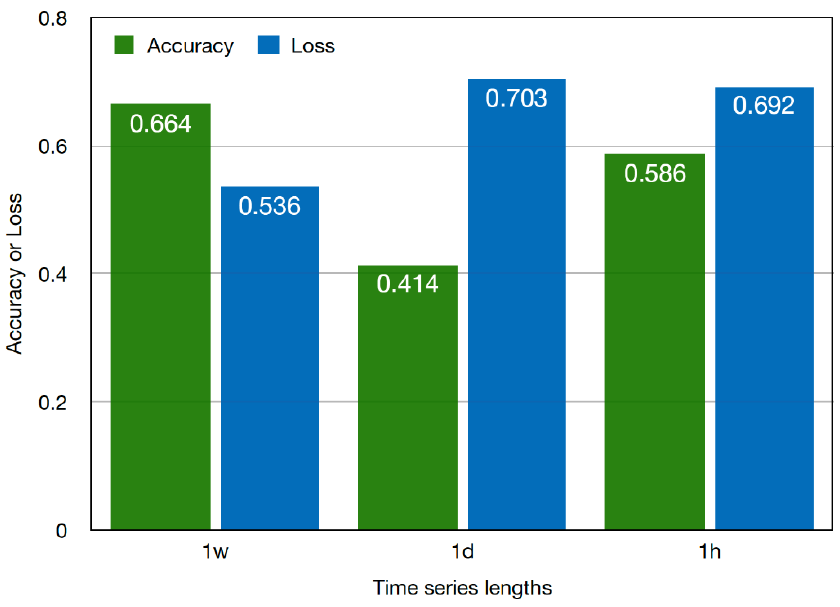
Figure 7. Validation accuracy and loss estimates for varying geomagnetic data lengths (1 week, 1 day, 1 h).